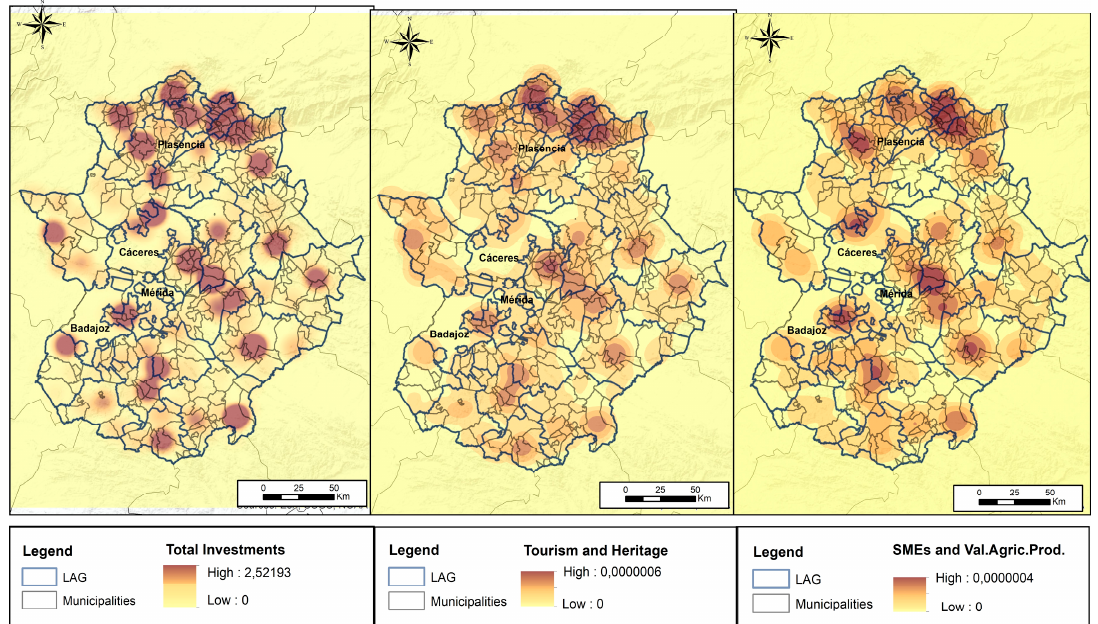
Figure 7. Kernel densities of LEADER Approach in Extremadura (2000–2013).